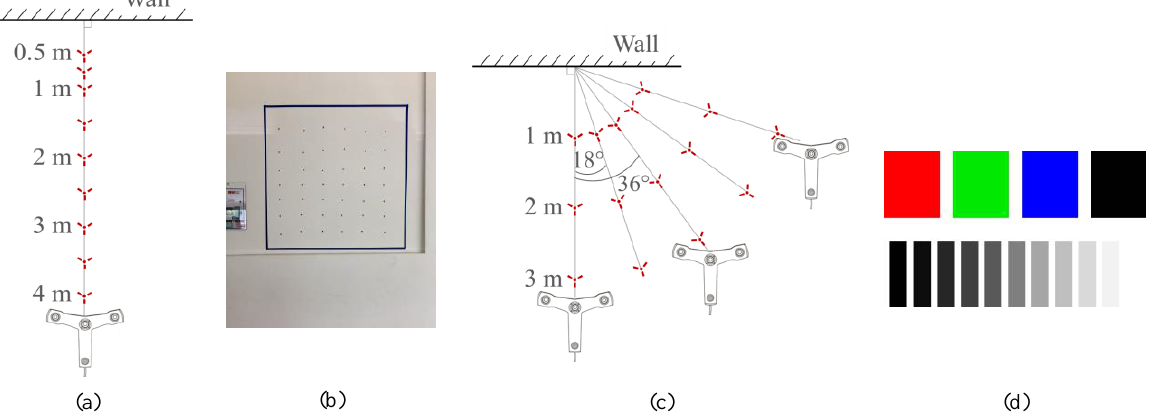
Figure 3. Investigation of factors influencing the measurement: (a) Setup of the experiment dealing with range influence. (b) The considered 1 × 1 m area used for the experiments. (c) Setup of the experiment dealing with the influence of incidence angle. (d) Color samples and shades of gray used to investigate color influence.